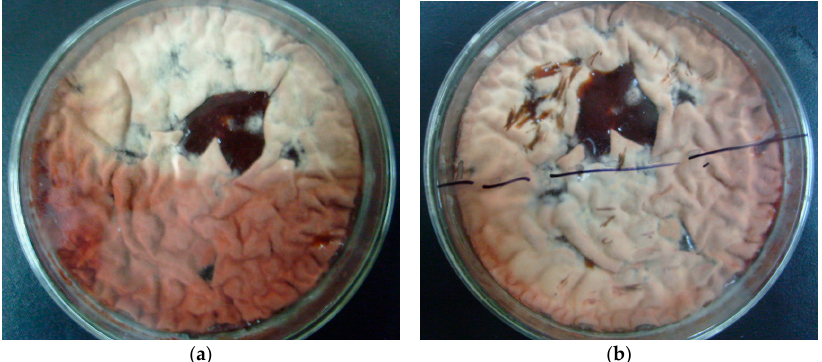
Figure 2. Changes in Monascus culture morphology after exposure to blue light. ( a ) Culture morphology of Monascus cultured under blue light for 5 days with tinfoil paper covering the bottom part; ( b ) Morphology of the culture in ( a ) exposed to blue light for additional 8 h after removing the tinfoil paper.